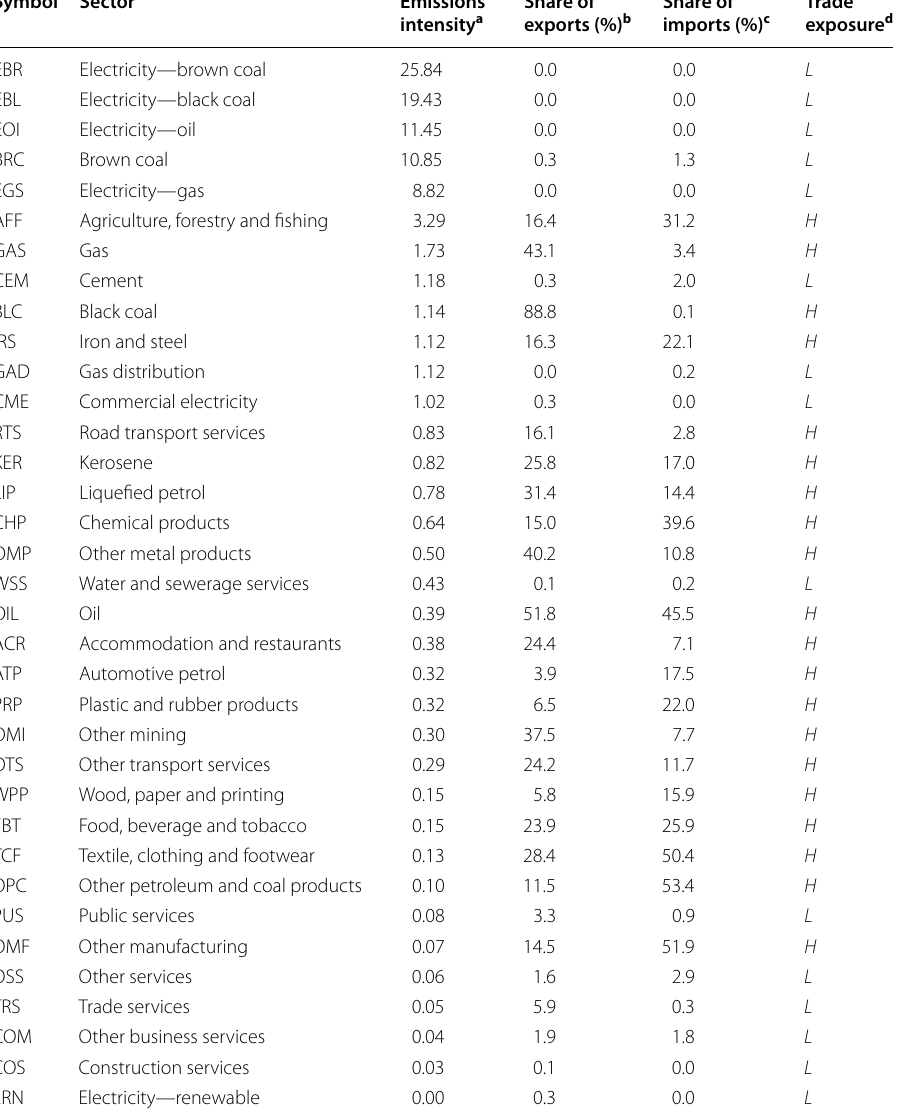
Table 1 Sectoral classification of the model Symbol